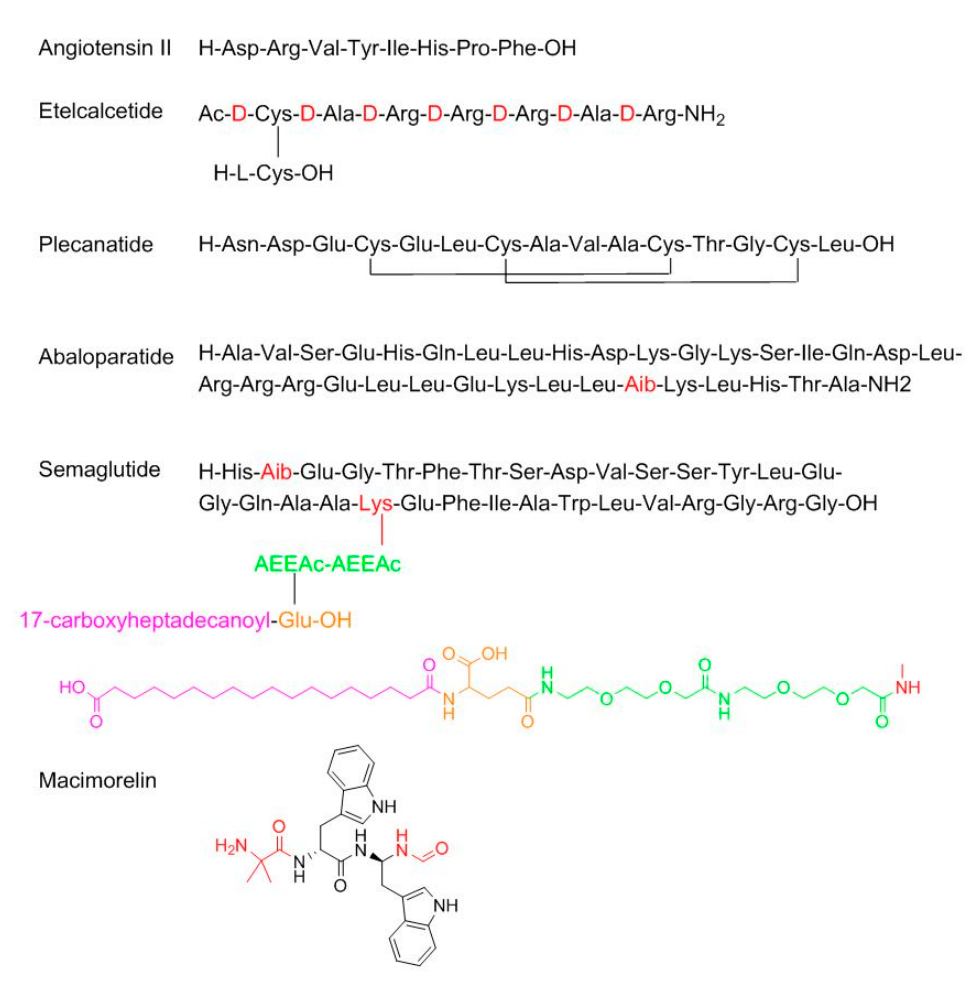
Figure 2. Structure of peptides. In red the non-proteinogenic or modified amino acids.